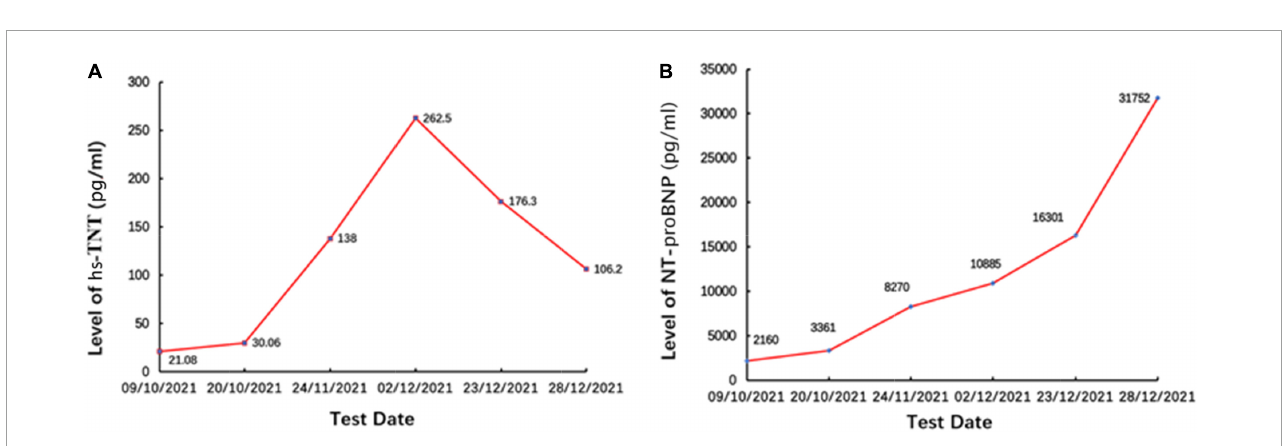
FIGURE4 The levels of (A) hs-TNT and (B) NT-proBNP. Panel (B) were persistently increased, demonstrating decreased cardiac